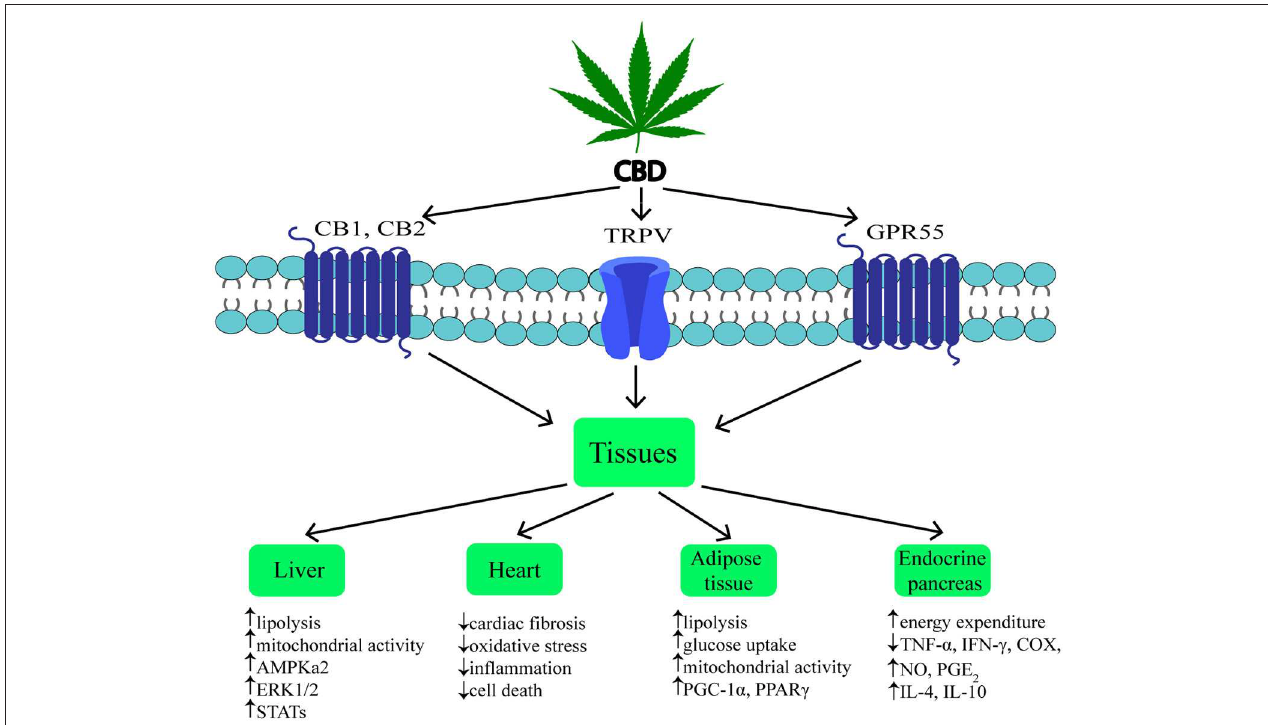
FIGURE 2 | Mechanism and effects of CBD action on various tissues during obesity. ↑ , increase; ↓ , decrease; CBD, cannabidiol; CB 1 , cannabinoid receptor 1; CB 2 , cannabinoid receptor 2; TRPV1, transient receptor potential channel of vanilloid type 1; GPR55, G protein coupled receptor 55; AMPKa2, catalytic subunit of AMP-activated protein kinase; ERK1/2, extracellular signal-regulated kinase; STATs, signal transducers and activators of transcription; PGC-1 α , peroxisome proliferator-activated receptor gamma coactivator 1-alpha; PPAR γ , peroxisome proliferator-activated receptor gamma; TNF- α , tumor necrosis factor alpha; IFN- γ , interferon gamma; COX, cyclooxygenase; NO, nitrogen oxide; PGE 2 , prostaglandin E2; IL-4, interleukin 4; IL-10, interleukin 10.